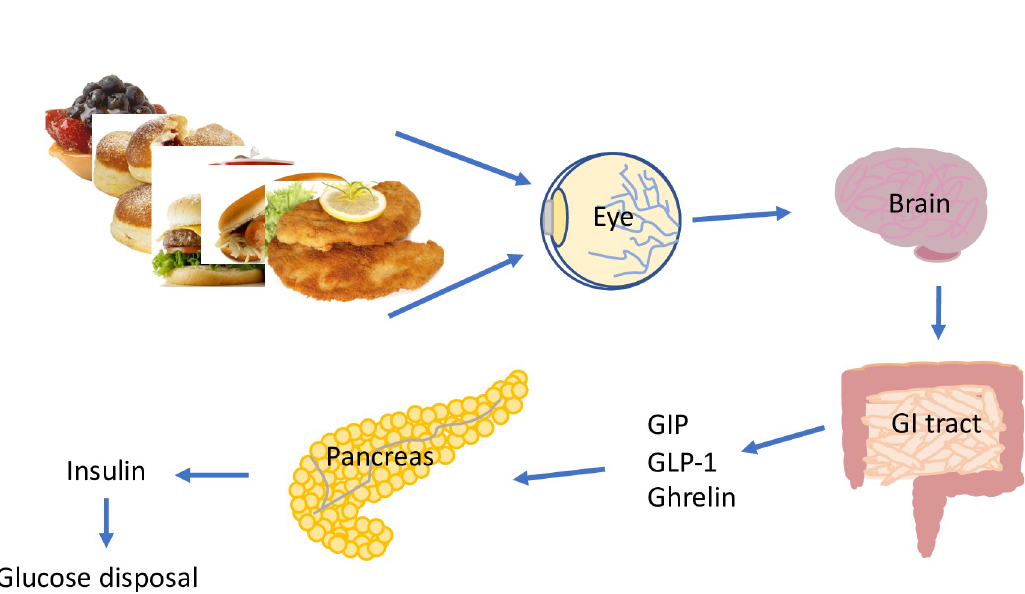
Fig 5. Schematic representation of the hypothesis. In study II, a small decrease in postprandial glucose concentration on S compared to NS day is observed for the first time point after the meal. Importantly, 1h after the meal, glucose concentrations drop further. This is most probably resulting from increased incretins and insulin concentrations and consequent glucose deposition. Interestingly, participants on the S day show delayed glucose decline and the most pronounced difference between NS and S day in glucose levels fits with the time point when the differences in GIP and GLP-1 concentrations between the two days of the study are the most pronounced. The differences between NS and S day imply that the efficacy of glucose uptake or deposition is affected by visual stimulation preceding a